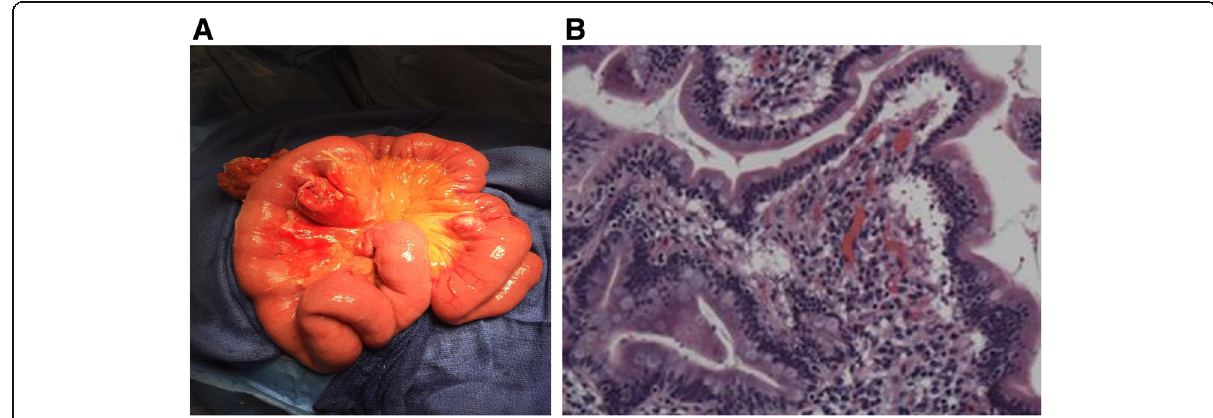
Fig. 2 Pathology. a Gross specimen of the resected jejunal segment containing the perforated diverticulum. b Histologic examination with transmural jejunal inflammation, serosal inflammatory exudate, and